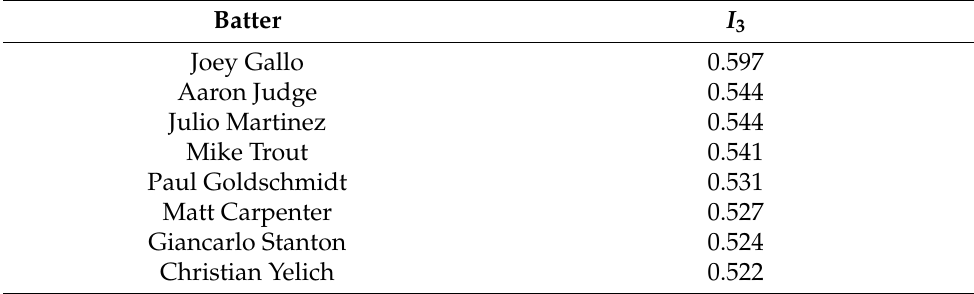
Table 3. Weighted on base average (wOBA) cube ( I 3 ) leaders for 2018.